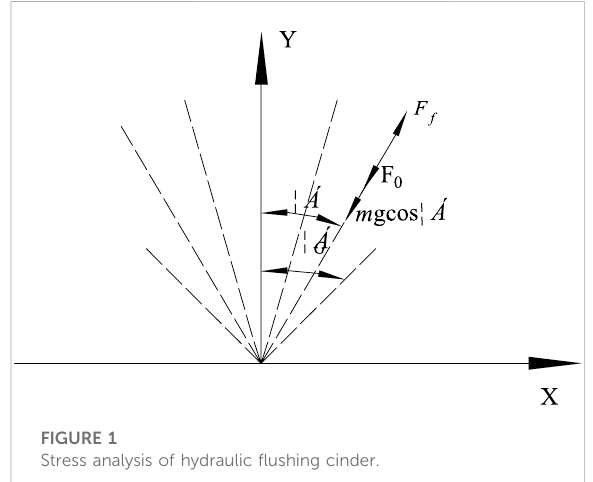
FIGURE 1 Stress analysis of hydraulic fl ushing cinder.